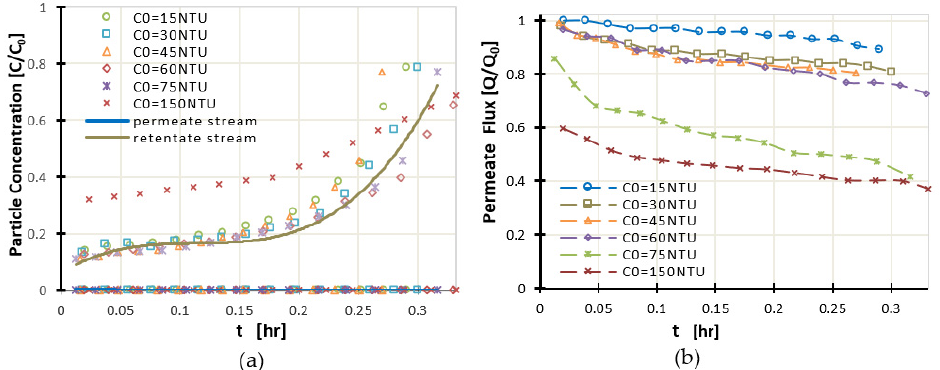
Figure 8. ( a ) Normalized particle concentration C/C 0 and ( b ) Normalized Permeate flux Q/Q 0, as functions of time. Effect of the feed stream initial turbidity on UF membrane efficiency.